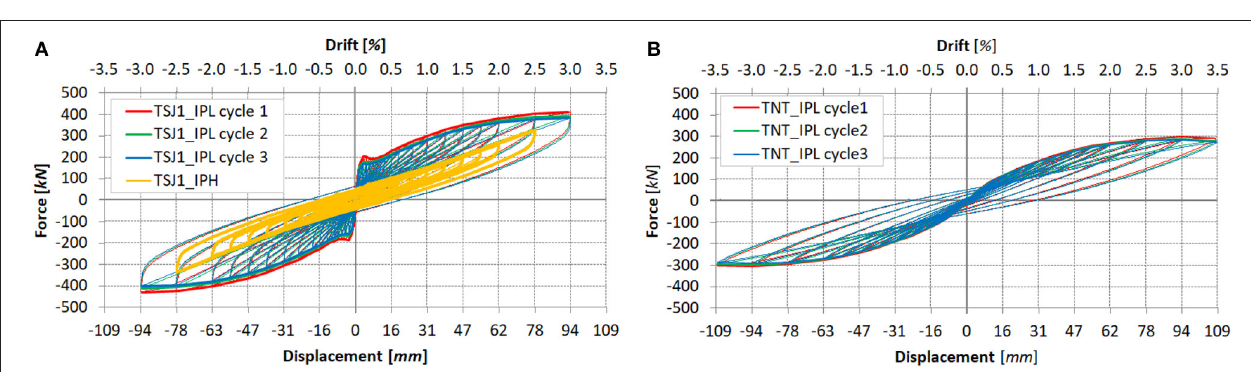
FIGURE 7 | Layout of the in-plane setup for cyclic tests.